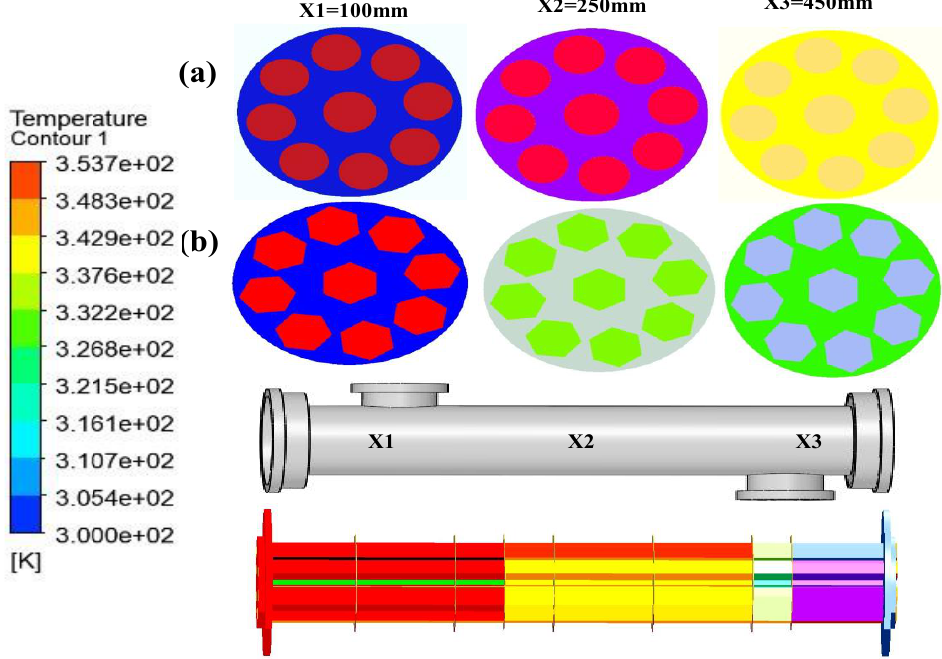
Figure 9. Temperature contours of ( a ) round tubes and of ( b ) hexagonal tubes of a heat exchanger.